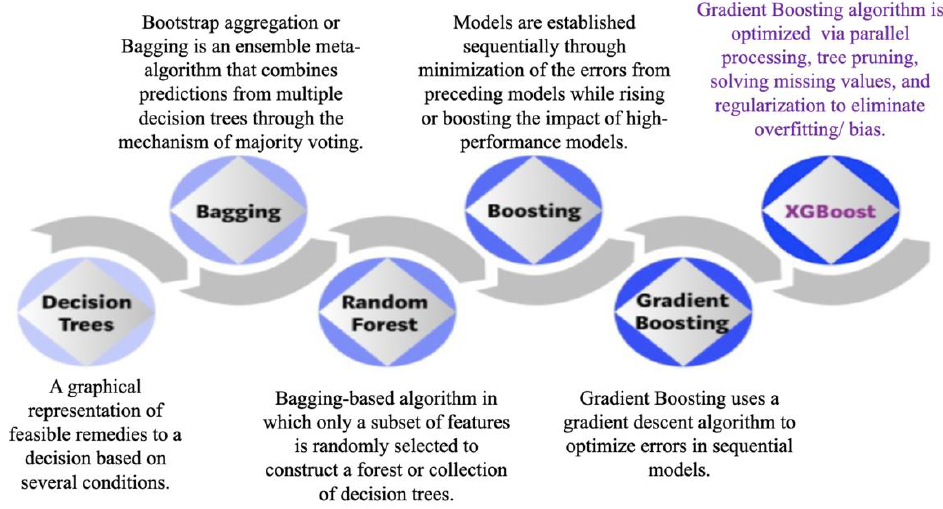
Figure 8. Evolution of XGBoost Algorithm from Decision Trees [40].